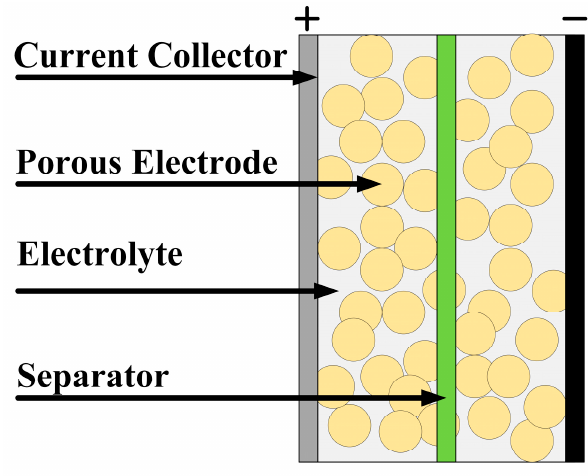
Figure 29. An UC cell; a separator keeps the two electrodes apart [58]. Figure 29 . An UC cell; a separator keeps the two electrodes apart [58]. Figure 29 . An UC cell; a separator keeps the two electrodes apart [58].